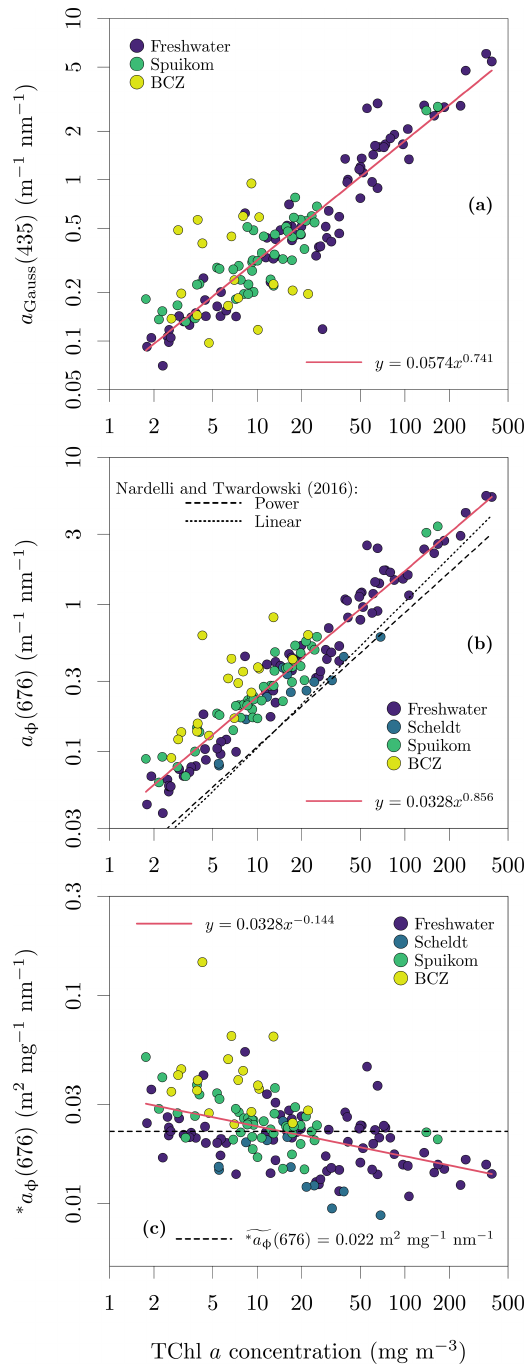
Figure 5. Relation between the total chlorophyll a (monovinyl chlorophyll a + chlorophyllide a ) and in vivo pigment absorption. (a) Magnitude of the Gaussian peak centred at 435nm; (b) the in vivo pigment absorption at 676nm, a (cid:56) (676); and (c) mass-specific in vivo pigment absorption at 676nm, ∗ a (cid:56) (676). The a (cid:56) (676) for the Scheldt samples was estimated as the a nw (650 , 676 , 715) line height (Roesler and Barnard,